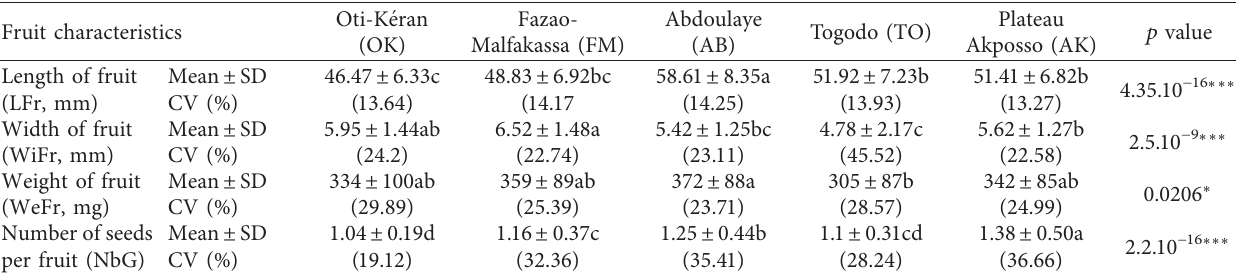
Table 10: Mean values and coefficients of variation (CV in percentage) of the variables of P. erinaceus fruits. Fruit characteristics